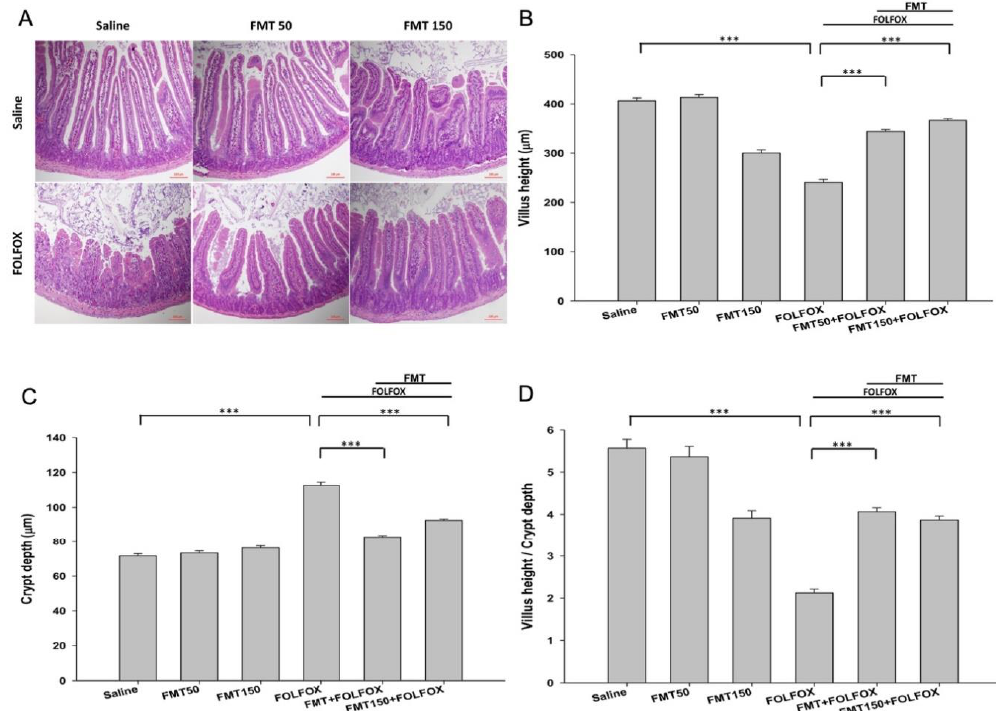
Figure 2. Histological changes in the jejunum of subcutaneously injected mice with colorectal carcinoma exhibiting FOLFOX-induced intestinal mucositis with/without FMT ( n = 6 for each group). Segments of the jejunum were harvested for ( A ) hematoxylin and eosin staining (scale bar = 100 µm) and measuring ( B ) villus height, ( C ) crypt depth, and ( D ) villus height-to-crypt depth ratio per mouse. FMT50: 50 mg/mL. FMT150: 150 mg/mL. Values are presented as mean ± SEM. ***: p < 0.001.